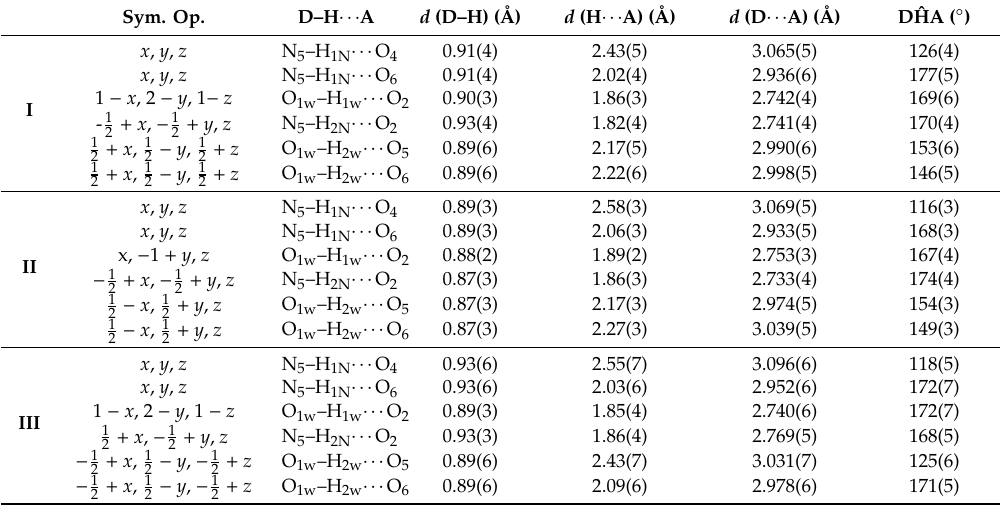
Table 1. Hydrogen bonding details for complexes I , II and III .